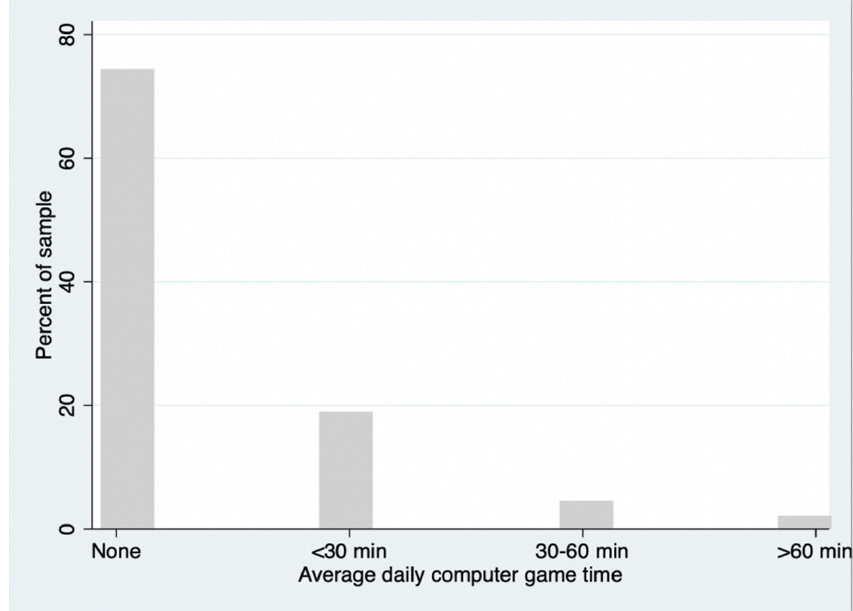
Figure 1. Histogram displaying average daily video game time of sample adolescents.